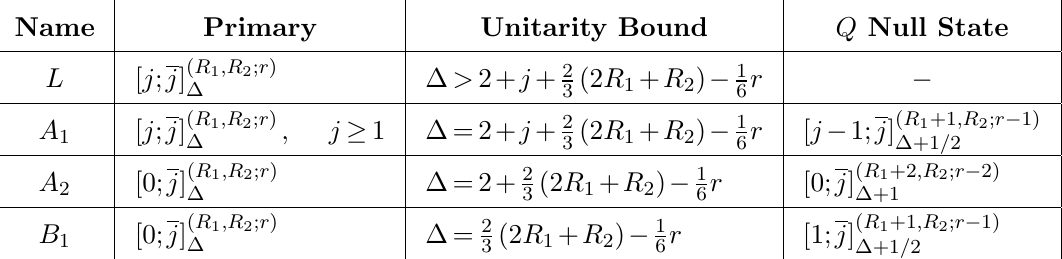
Table 16 . Q shortening conditions in four-dimensional N = 3 SCFTs.